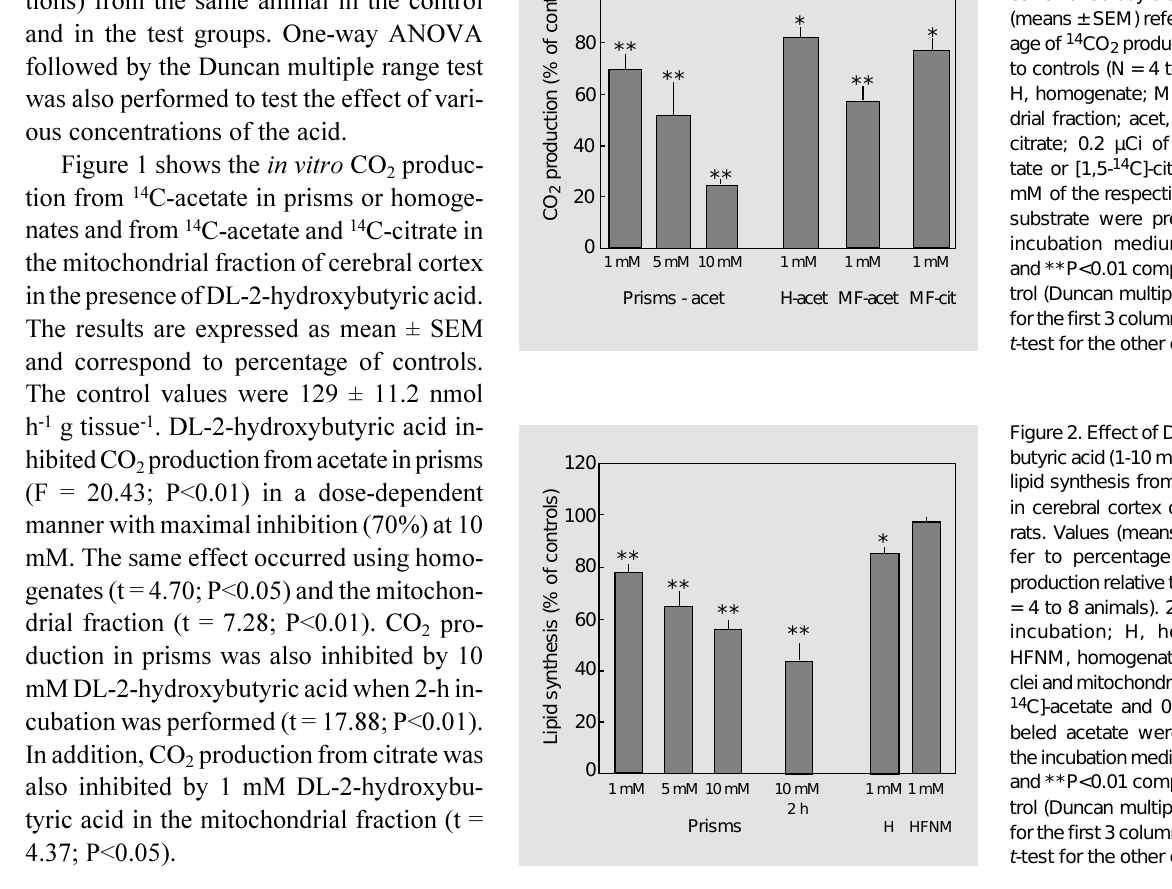
Figure 1. Effect of DL-2-hydroxy- butyric acid (1-10 mM) on the in vitro CO 2 production from 14 C- acetate or 14 C-citrate in cerebral cortex of 30-day-old rats.